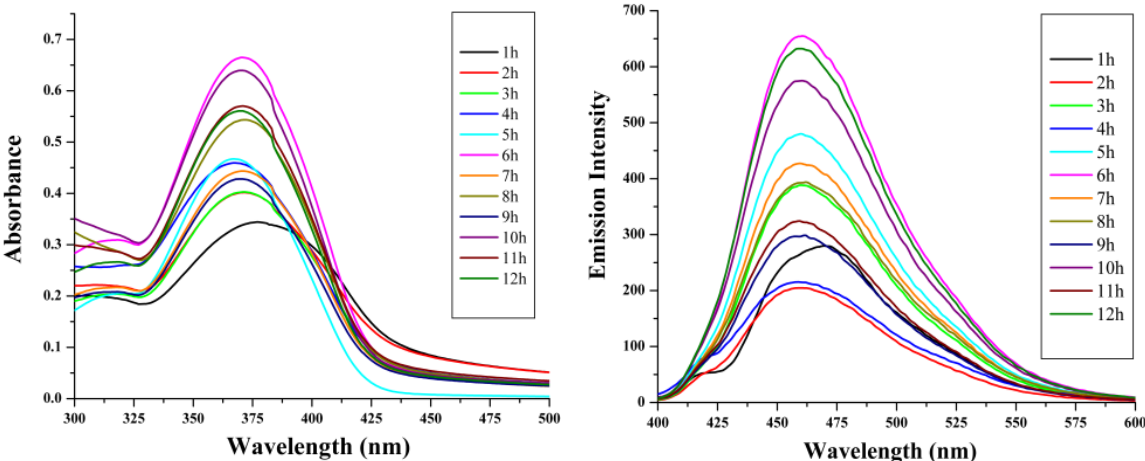
Figure 3. The UV-Vis absorption and emission spectra of 1h-12h .